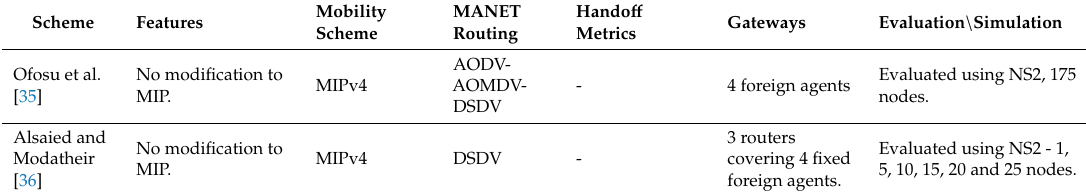
Table 1. Proactive gateway discovery-based mobility management